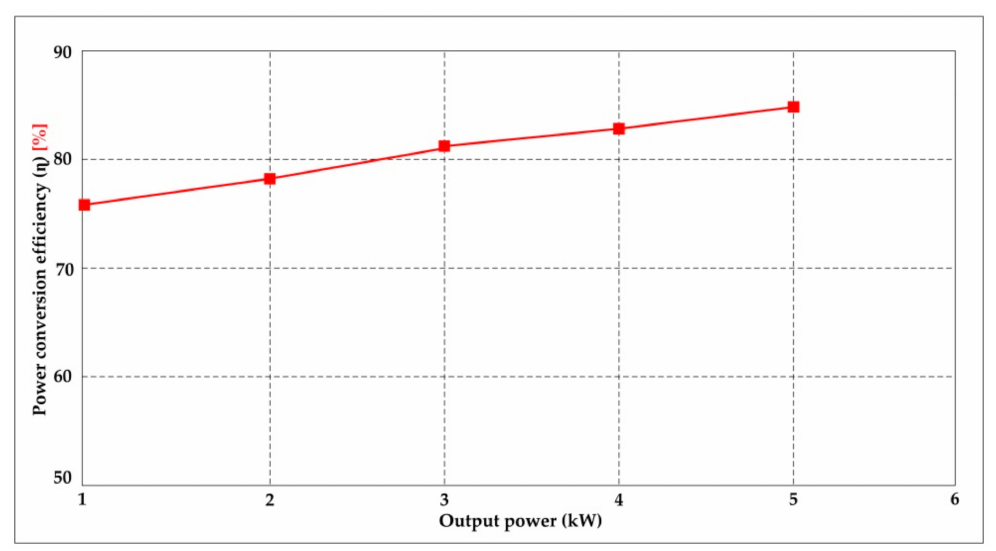
Figure 11. Power conversion